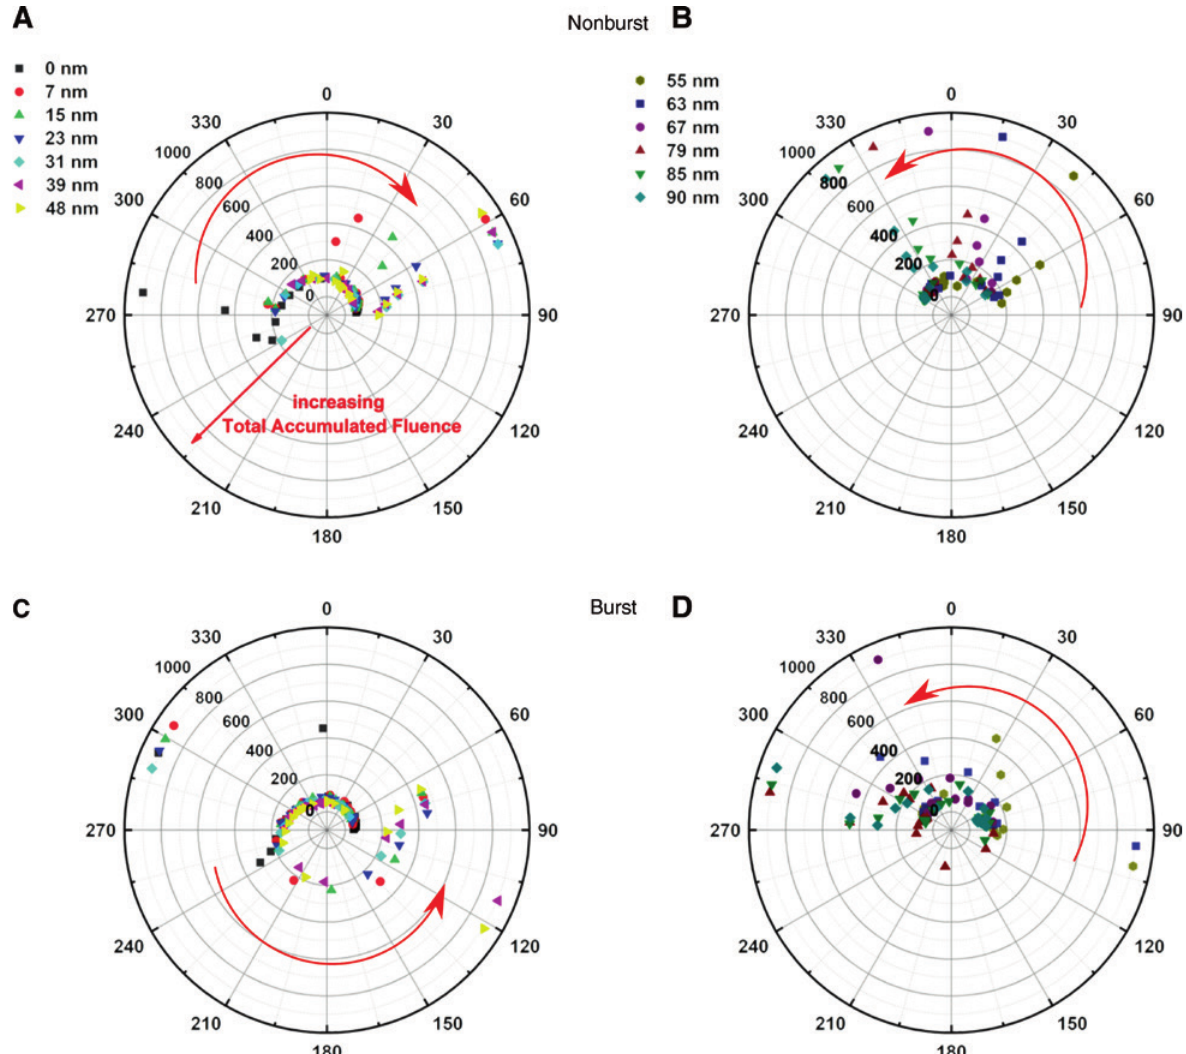
Figure 4: Hue values of colours with increasing ALD thickness. Polar plots of hue ( θ ) versus total accumulated fluence ( r ) for the (A, B) nonburst and (C, D) burst colours with increasing alumina thickness. The different points in the plots represent the hue range of the colour palette for a certain alumina thickness. The evolution and displacement of the hue values with increasing alumina thickness is displayed by the red